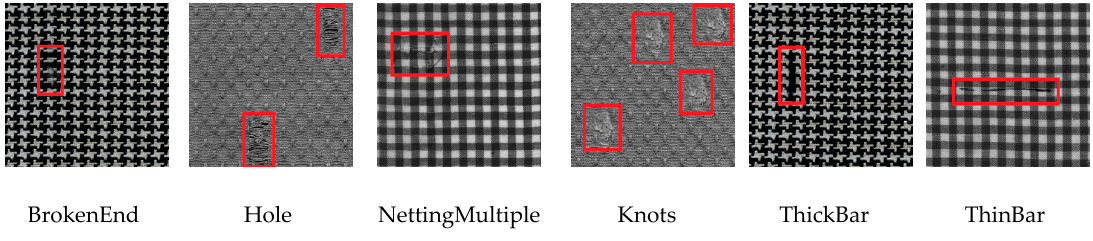
Figure 8. Illustration of images on Hong Kong dataset.